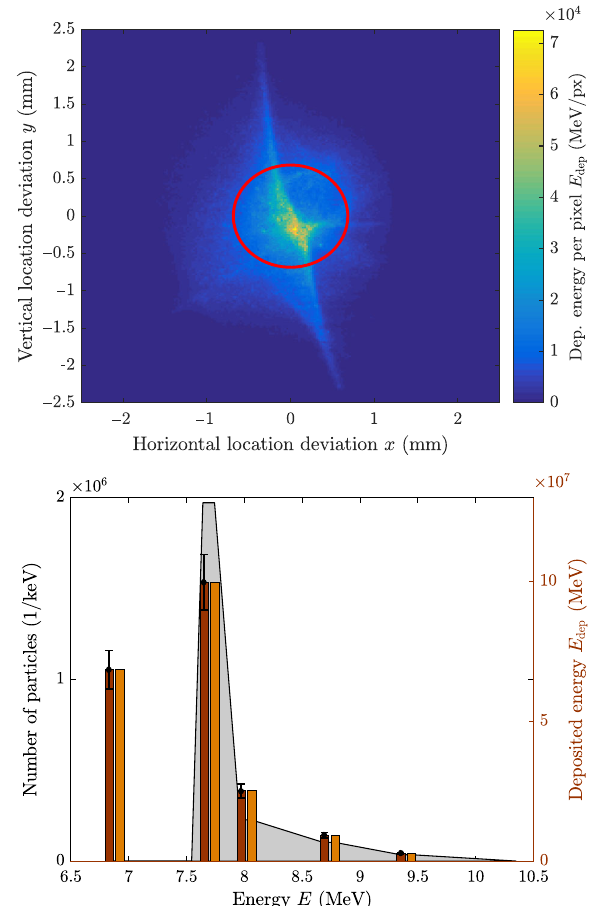
FIG. 8. In the upper picture, the deposited energy of the longitudinally and transversely focused proton bunch is shown in the active layer, in which particles with an energy of 7.7 MeV have been stopped. The red circle is enclosing 50% of the total deposited energy in this layer and has a 1.38 mm diameter. In the lower picture, the total measured deposited energy in all the five active layers (red bars) of the stack and a calculated energy spectrum (gray) which would deposit the same energy in these active layers (orange bars) is illustrated. More information on the reconstruction of this energy spectrum is provided in Sec.